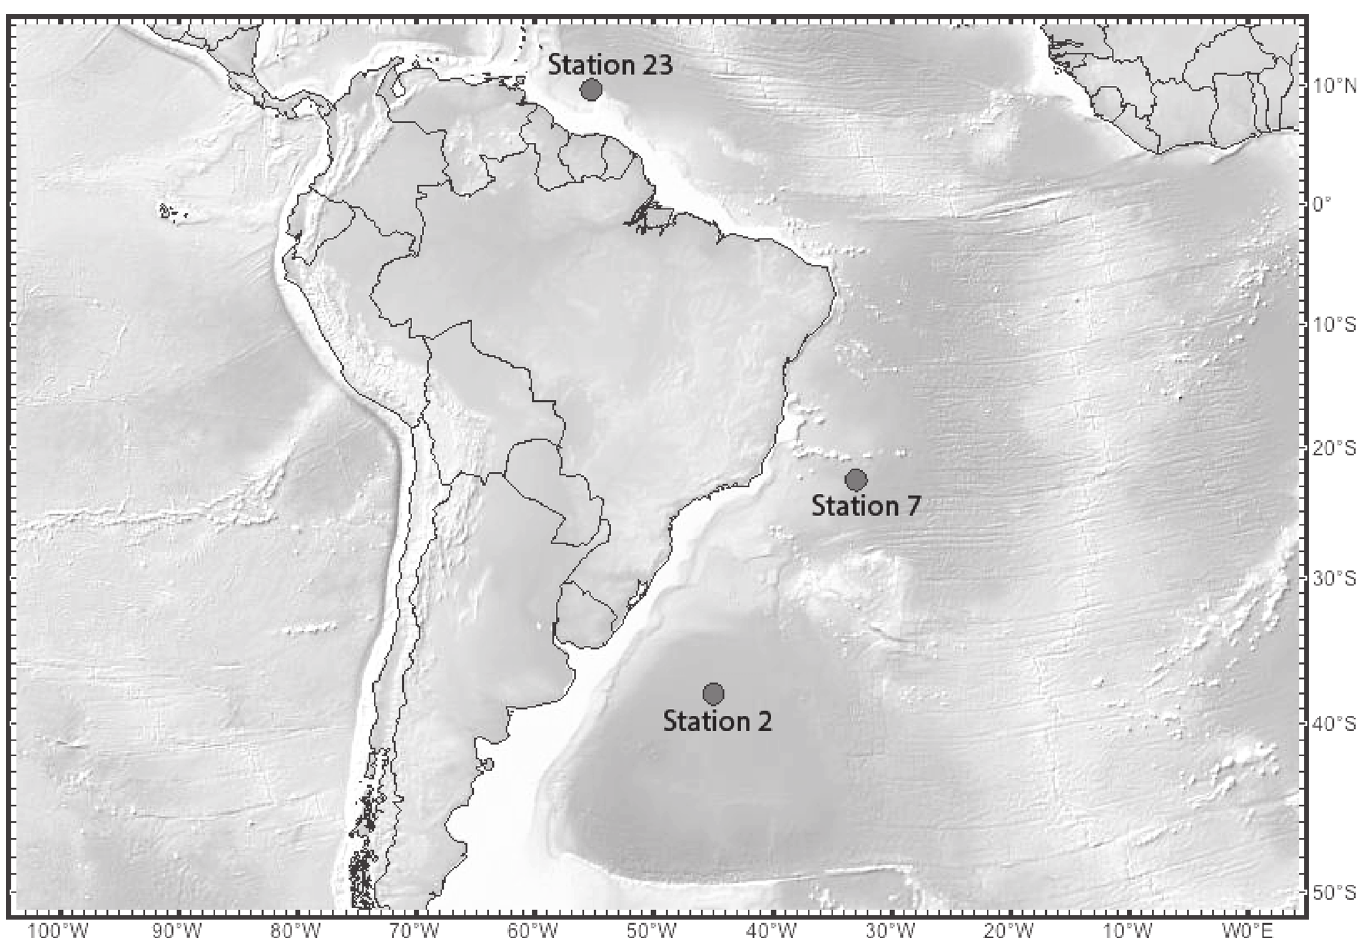
Fig 1. Map of the station locations used in this study, marked as stations 2, 7 and